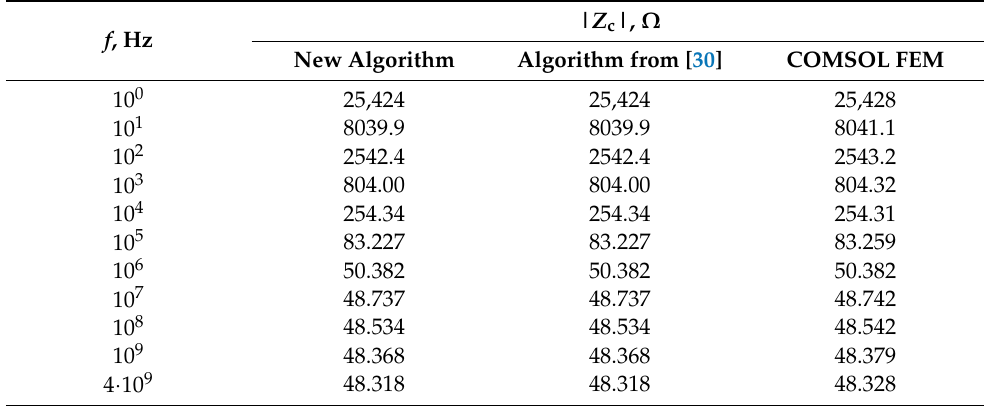
Table 1. Comparison of the characteristic impedance for the first validation example.